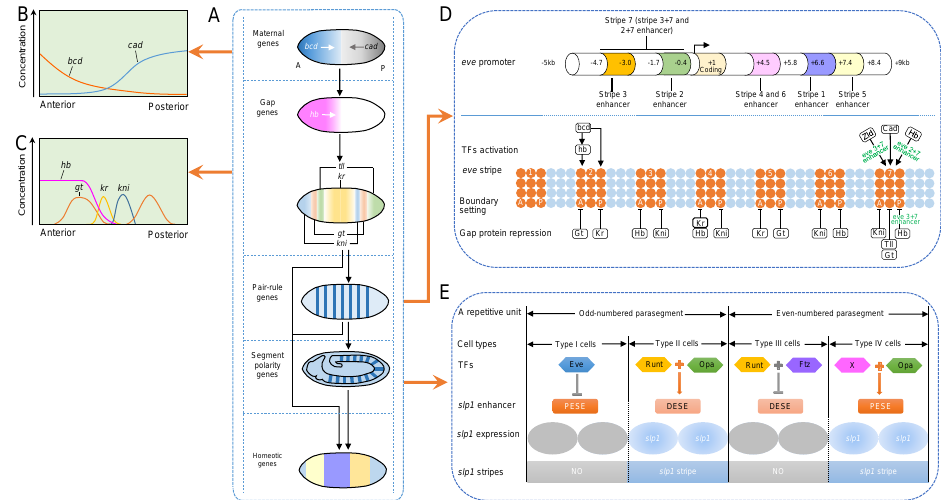
Figure 3. Establishment of the embryonic anterior–posterior (A-P) axis in Drosophila . The diagram is adapted from Gilbert’s works [40,41] . ( A ) Regulatory hierarchy of the formation of Drosophila A-P axis patterning. The maternal effect proteins Bicoid (Bcd) and Caudal (Cad) form a concentration gradient along the A-P axis and generate specific positional information to activate the expression of the gap gene hunchback ( Hb ). Hh further initiates the proper expression of other gap genes along the A-P axis. Gap proteins subsequently activate the expression of pair-rule genes, which form seven stripes perpendicular to the A-P axis and divide those discontinuous regions defined by the gap gene into body segments. The pair-rule proteins then regulate the expression of segment polarity genes in specific cells of each somite, and their 14 expression stripes establish the boundaries of parasegments. Finally, each segment is characterized by specifically expressed Hox genes. ( B ) The concentration gradient of the maternal effect proteins Bcd and Cad along the A-P axis in the early cleavage embryo. ( C ) The concentration changes in gap genes along the A-P axis. ( D ) Regulation of expression of the pair-rule gene even-skipped ( eve ) in seven stripes. The above region represents a partial promoter of the eve gene that contains five different enhancers responsible for the distinct stripes. The lower part illustrates how TFs regulate eve expression in different stripes. The black box represents the TF, the green characters indicate the enhancer of eve , and the orange circles display the cells expressing eve . The vertical bars with the letters “A” and “P” denote the anterior and posterior boundaries of the eve stripe, respectively, and the numbers show the number of eve bands. ( E ) Regulation of a repetitive unit of sloppy paired 1 ( slp1 ) stripe [42] . The 14-stripe patterning constitutes seven repetitive units, each containing odd-numbered and even-numbered parasegments. The odd-numbered parasegment consists of two types of cells: two type I cells in the posterior half do not express slp1 and two type II cells in the posterior half that express slp1 . The even-numbered parasegment also contains two types of cells: type III cells that do not express slp1 in the first half and the latter type IV cells expressing slp1 . The expression of slp1 in different cell types is regulated by different pair-rule proteins in a specific combination to regulate the proximal early stripe element (PESE) or the distal early stripe element (DESE) of slp1 . The colored hexagons indicate the pair-rule proteins, the orange quadrants represent the enhancer, the gray ovals exhibit the cells that do not express slp1 , the blue ovals denote the cells expressing slp1 , the gray rectangles with “No” show no slp1 strips, and the blue rectangles represent slp1 strips. TF abbreviations: Hb: Hunchback; Gt: Giant; Kr: Krüppel; Kni: Knirps; Tll: Tailess; Zld: Zelda; Opa: Odd-paired; Ftz: Fushi tarazu; X: represents an as yet unidentified Factor X.